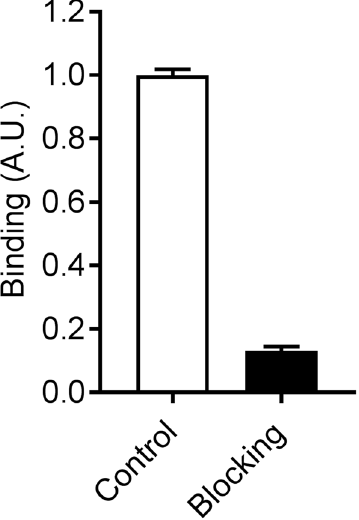
Figure 9. Ex vivo binding of 99m Tc-RYM1 to lung tissue from lung-specific interleukin-13 transgenic mice without (control) or with (blocking) co-incubation of excess precursor, RYM. The data represent the mean ± SD of duplicate determinations. A.U.: arbitrary